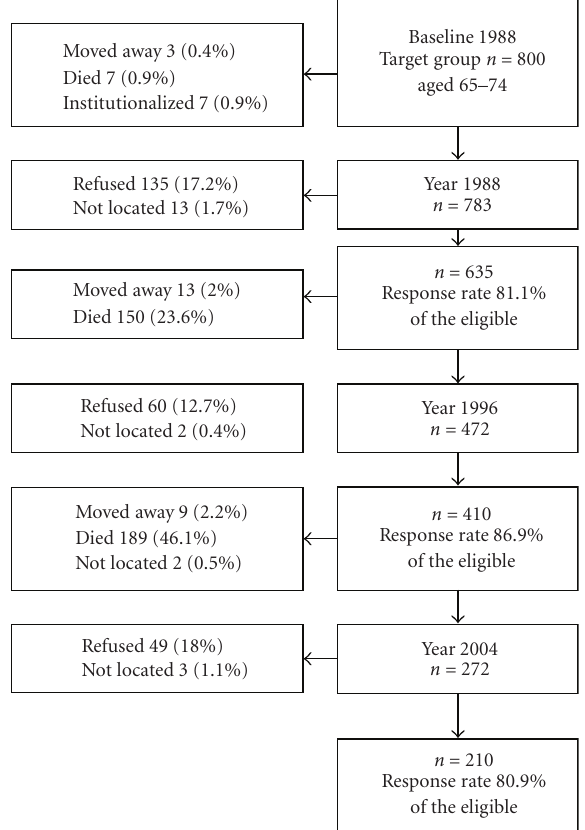
Figure 1: Participation in the